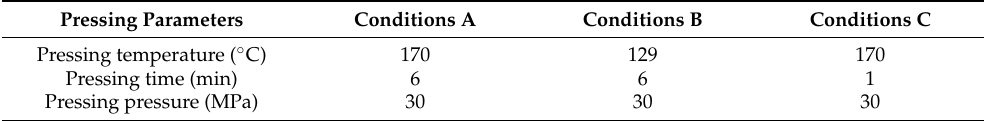
Table 1. Compression-cooking process